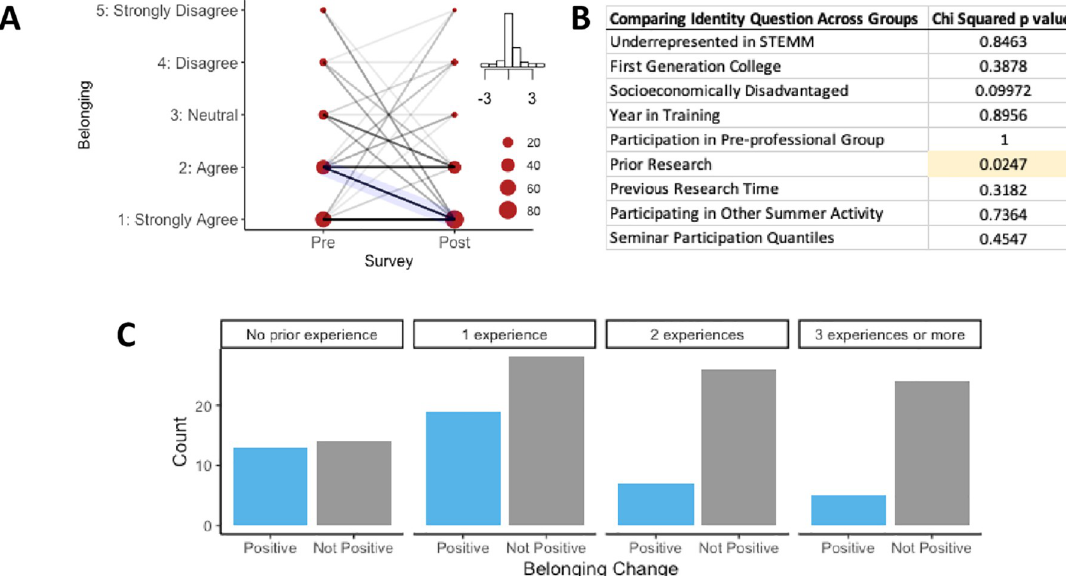
Fig 2. While most students started the program with a strong sense of belonging, students with a positive change in the sense of belonging had less prior research experience. (A) We examined student’s responses to the prompt, "I have a strong sense of belonging with the STEMM community." Responses are shown based on a 5-point Likert scale, with one indicating that they strongly agreed with the statement to five indicating that they strongly disagreed with the statement. The inset is a histogram of the change in values (pre-test minus the post-test value) with the highest bar at 0, indicating no change in response. (B) Demographic information in individuals with positive (improved) “Belonging” change compared with those without a positive change were analyzed using a Chi-squared analysis. (C) The positive (improved) change versus non-positive change in belonging were compared with amount of research experience, no prior experience, one, two, or three or more